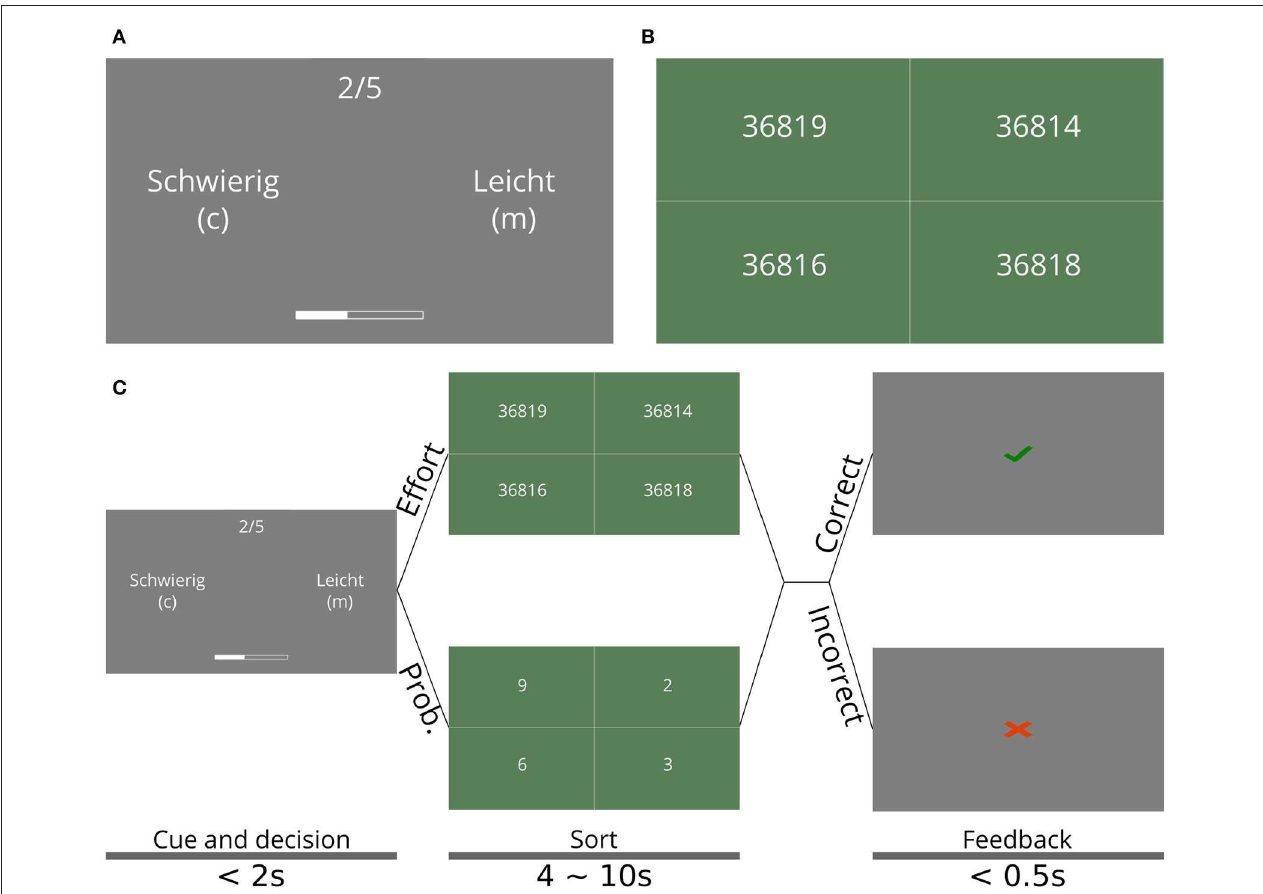
FIGURE 1 | Effort and sequential task. (A) Cue and decision phase of the sequential task. Participants had to choose between the easy option (Leicht, in the original German), which corresponded to the probabilistic option (see main text), and a hard option (Schwierig), which corresponded to the effortful option, which lead to the task shown in (B) . The choice was made with keyboard keys C and M, for the option on the left and right, respectively; the side on which each option appeared is randomly selected at every trial. The trial number is shown on top as 2/5, which means the second trial out of five (B) Number-sorting task, where participants had to select the shown numbers in ascending order to correctly complete a single trial of the sequential effort-investment task. To select a single number, participants could click anywhere in the box containing this number. (C) Schedule of the different phases of a single trial in the sequential task. The shown screens are those in (A,B) . The times for each screen are shown at the bottom, along with the name of each phase. Note that the time allotted to sorting the numbers was the same both for the probabilistic (leicht) or effortful (schwierig) option. The main experiment consisted of 25 mini-blocks (sequences of trials) with ten trials each. The text size on (A,B) was increased for visual